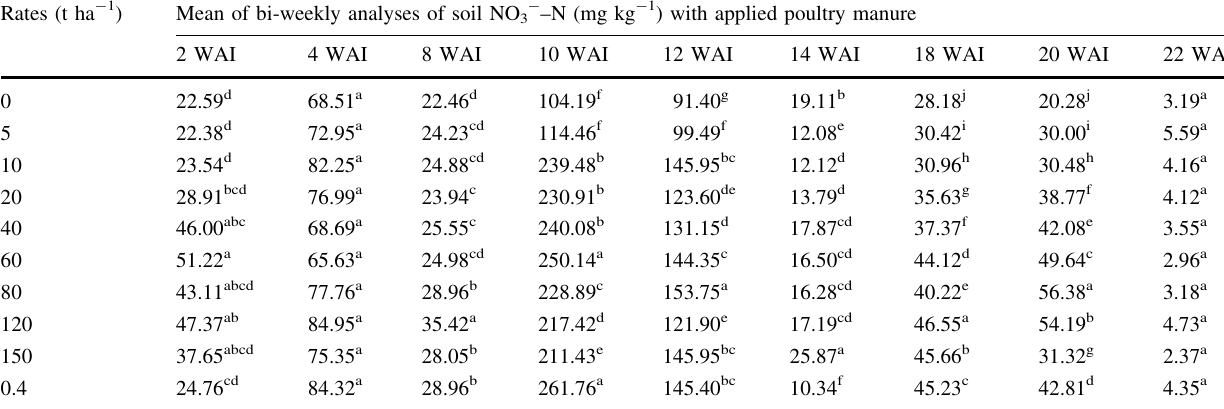
Table 10 Influence of poultry manure rates and NPK fertilizer (t ha - 1 ) on mean soil NO 3 - –N (mg kg - 1 ) at 2 weeks intervals Rates (t ha - 1